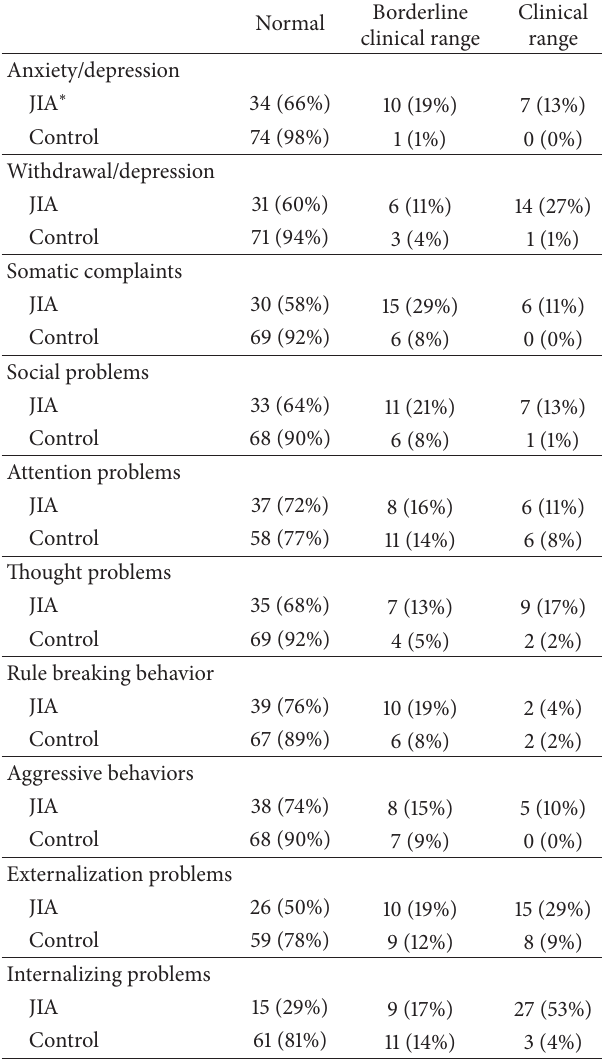
Table 2: The rate of behavioral problems (ranging from normal to clinical range) measured by CBCL in both